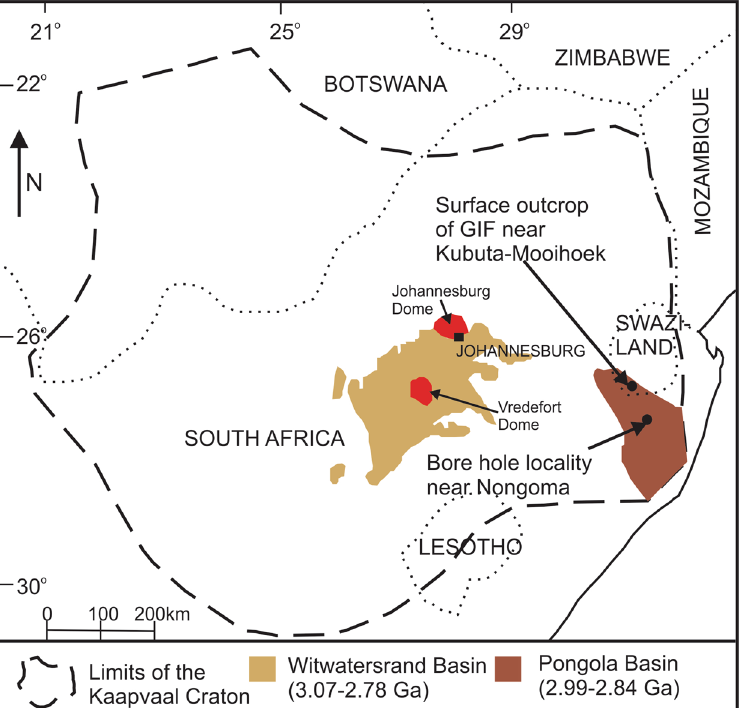
Figure 1. Location of the Pongola Supergroup as well as the studied outcrop and drill core localities on the Kaapvaal Craton of southern Africa. The figure is adapted from 25 . The figure was created using CorelDRAW